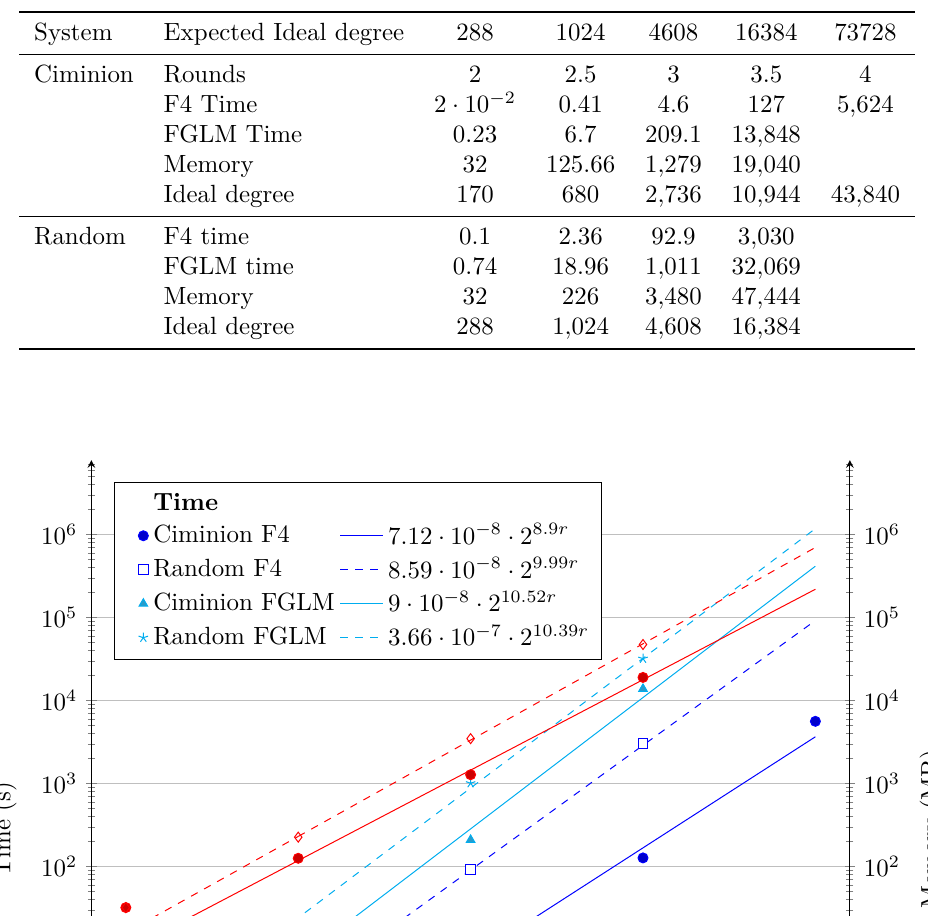
Table 6: Benchmarks of multivariate root finding with Magma using 1 CPU core of an Intel Xeon Gold 5218, for Ciminion and Ciminion-like systems. Times are given in seconds and memory usage in MegaBytes, for systems of 𝑛 equations of degree 3-round and 4-round Rescue-prime respectively correspond to 𝑛 = 6 and 𝑛 = 9.